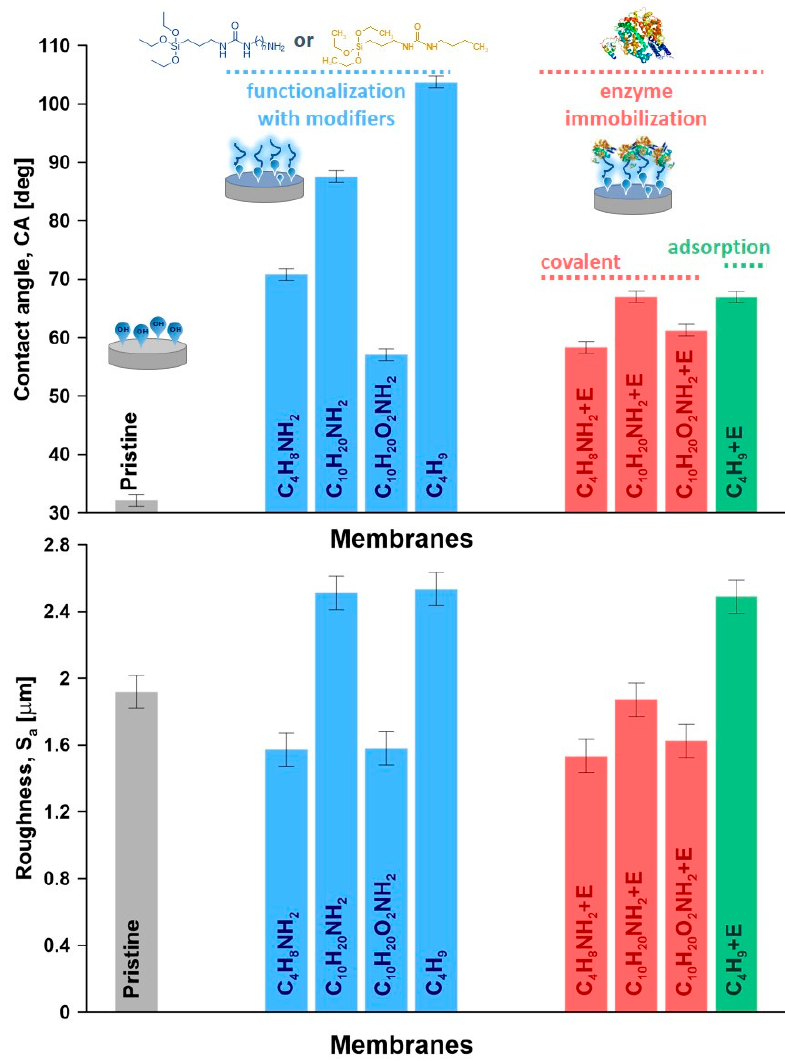
Figure 5. Apparent contact angle and roughness parameters (S a —arithmetic average) for the pristine, functionalized and immobilized materials.